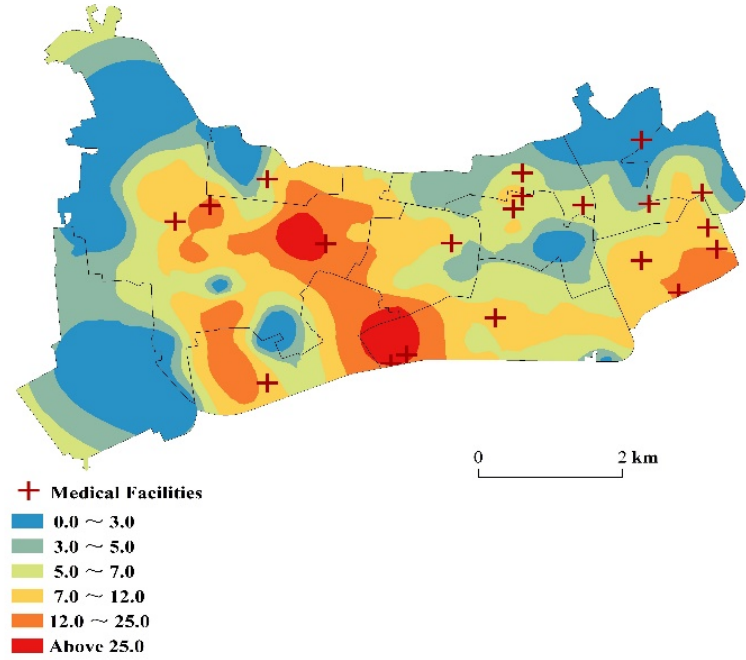
Figure 6. Accessibility distribution of medical facilities in Changning District.